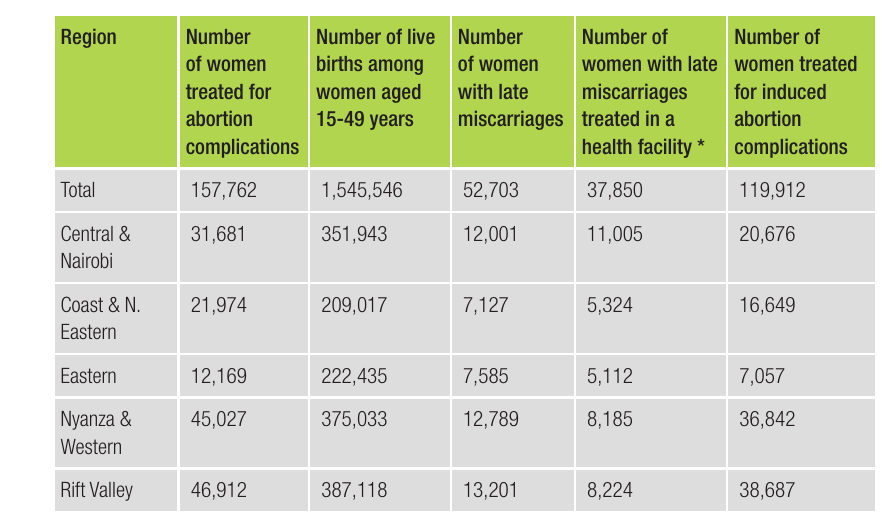
Table 3 Estimated number of women treated for complications of induced abortions in a health facility by region, Kenya,